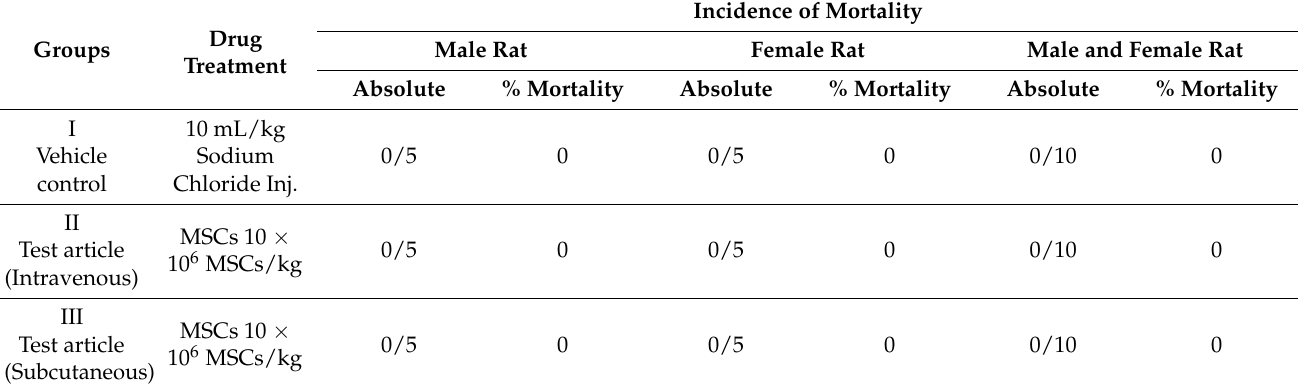
Table 4. Summary of mortality.